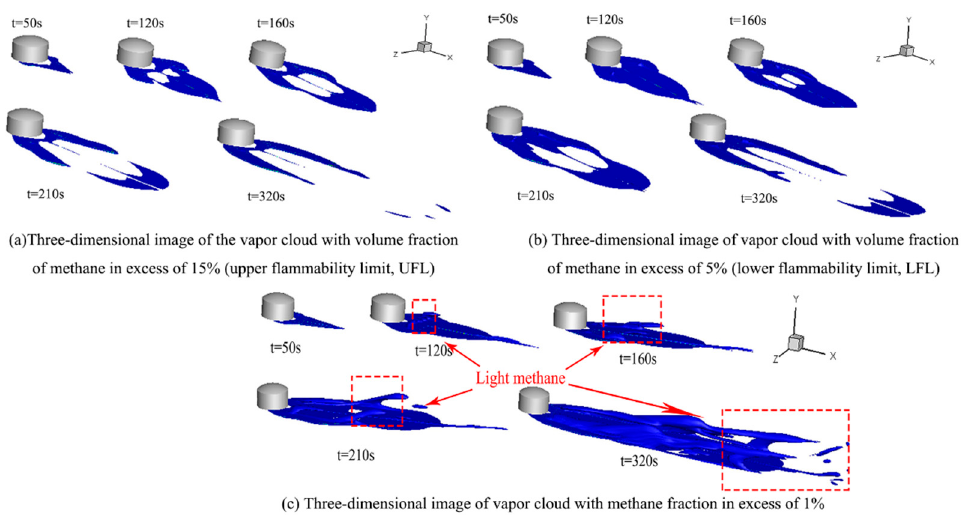
Figure 8. Three-dimensional perspectives of gas clouds with different methane volume concentra- tions at different leakage moments. ( a ): Three-dimensional image of the vapor cloud with volume tions at different leakage moments. ( a ) Three-dimensional image of the vapor cloud with volume fraction of methane in excess of 15%(upper flammability limit, UFL); ( b ): Three-dimensional image fraction of methane in excess of 15%(upper flammability limit, UFL); ( b ) Three-dimensional image of vapor cloud with volume fraction of methane in excess of 5%(lower flammability limit,LFL); ( c ): Three-dimensional image of vapor cloud with methane fraction in excess of 1%. ( c ) Three-dimensional image of vapor cloud with methane fraction in excess of